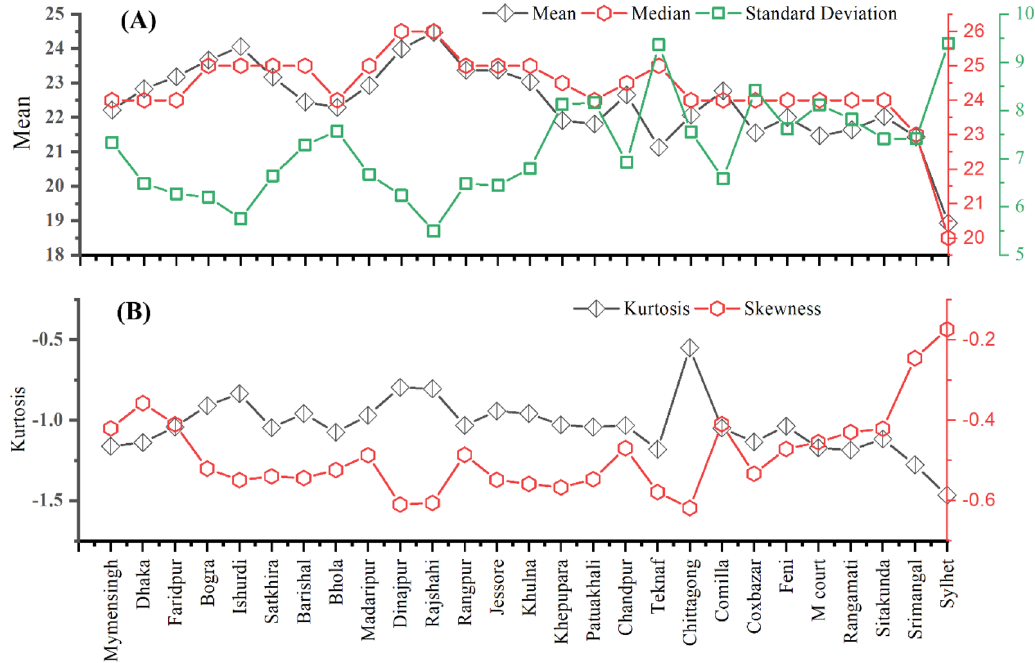
Figure 1. Descriptive statistics of MDD of all stations in this